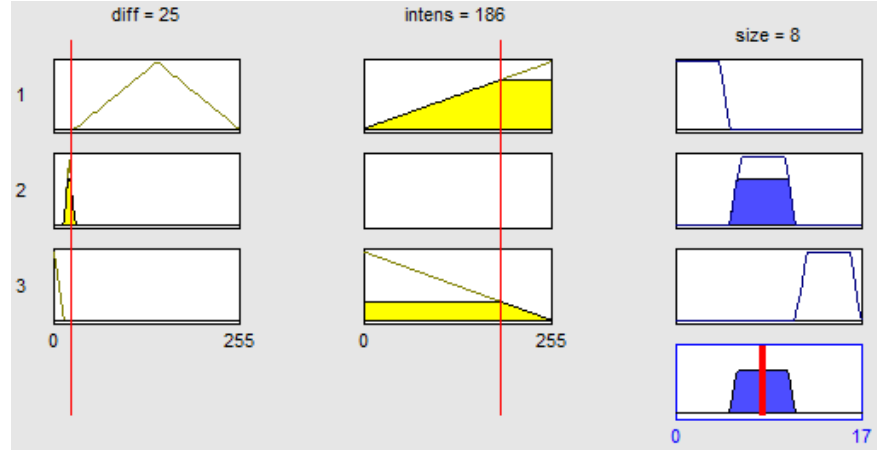
Fig. 7. Defuzzification with the centroid